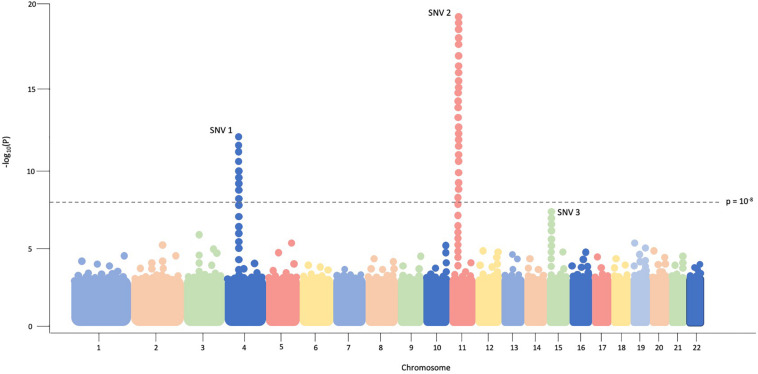
In this example Manhattan plot, each dot represents a single SNV assessed in every individual in the cohort. Genomic coordinates are displayed in ascending fashion on the X-axis, beginning with chromosome 1 on the left. The negative logarithm of the association p-value for each SNV is shown on the Y-axis. The SNVs with the strongest association will have the most negative p-value, so the negative logarithm will be greatest for these SNVs. In this example plot, SNV1 and SNV2 exceed the threshold of significance (p = 10– 8) while SNV3 does not.